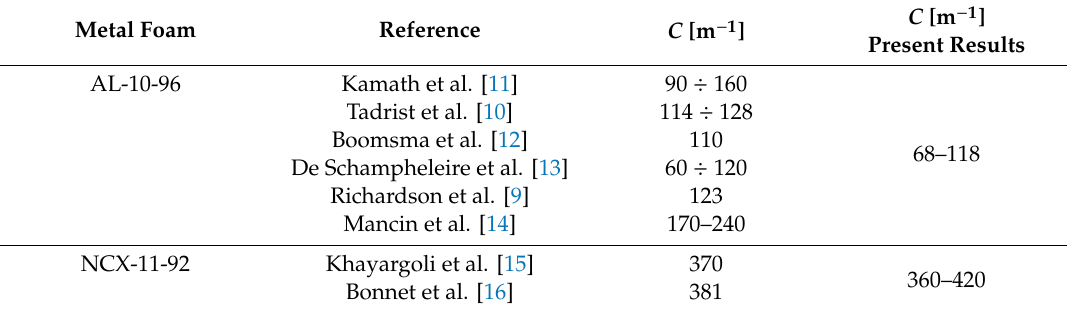
Table 2. Comparison of the obtained inertia coe ffi cients C values with literature values for similar foams. Metal